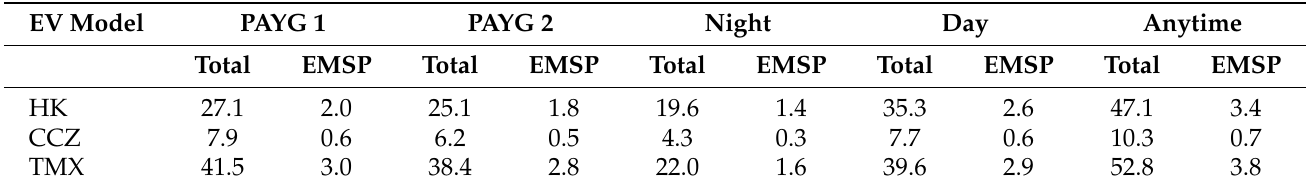
Table 6. Charging-event related costs for EV driver in